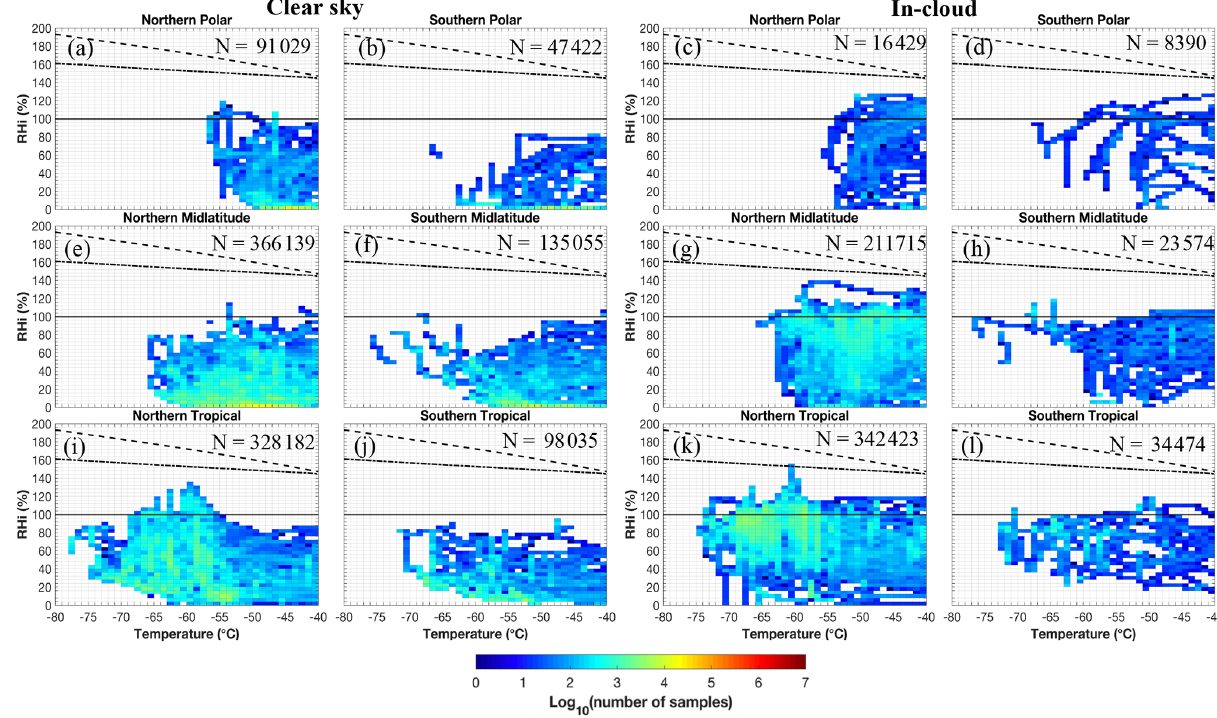
Figure 7. Similar to Fig. 6 but for 430s